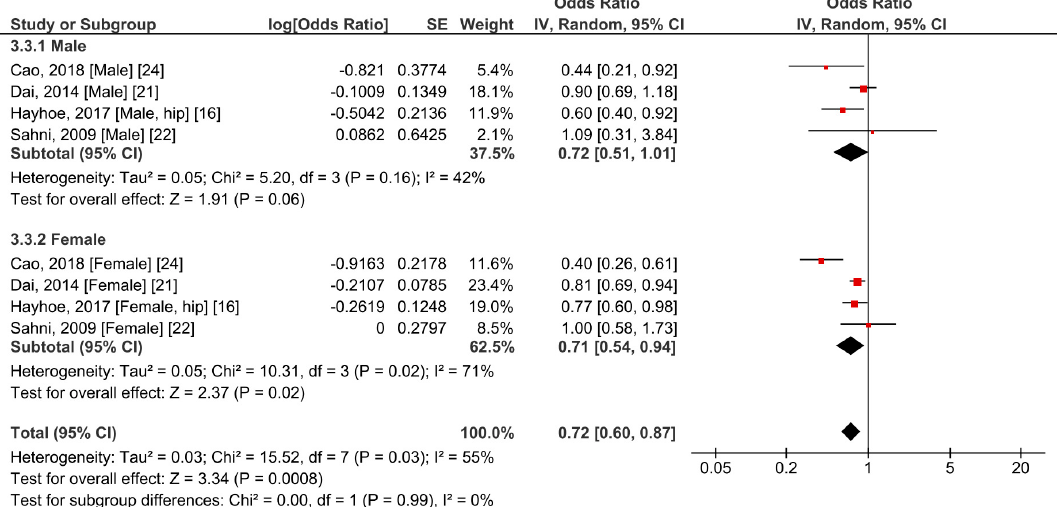
Figure 4. Meta-analysis results of BCX intake and hip fracture in males and females.